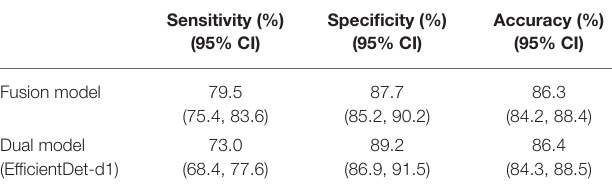
TABLE 5 | The performance of HE detection in dual and fusion models.